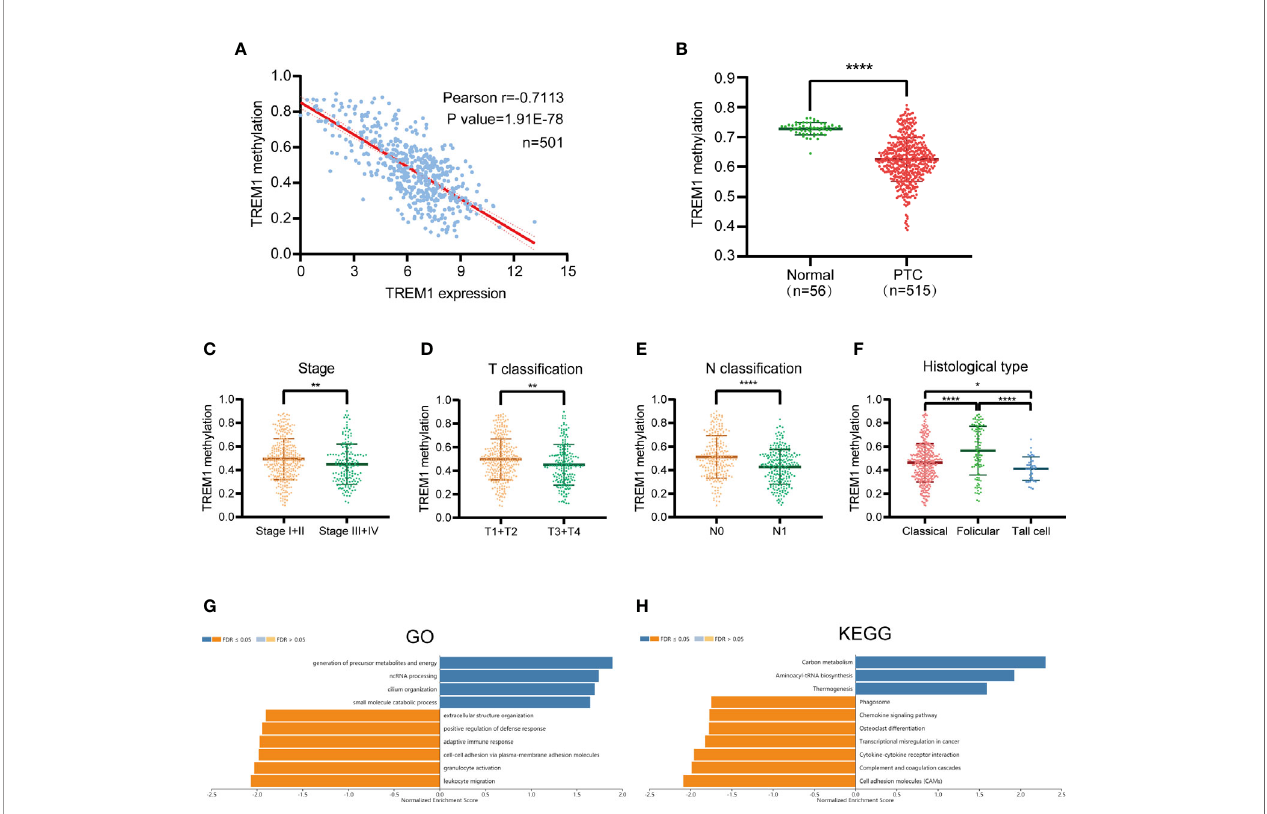
FIGURE 5 | TREM-1 Methylation in PTC. (A) Correlation analysis between TREM-1 methylation and TREM-1 expression in PTC (B) TREM-1 methylation levels were compared between PTC and normal tissues. TREM-1 methylation level among patients with different (C) clinical stages, (D) T classi fi cations, (E) N classi fi cations and (F) histological types of PTC. (G) GO biological process terms and (H) KEGG pathways signi fi cantly altered by TREM-1 methylation in the THCA cohort. *P < 0.05, **P < 0.01 and ****P < 0.0001